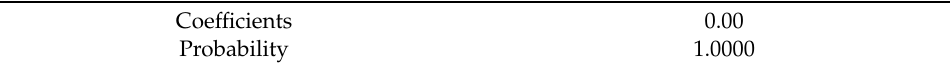
Table A2. Breusch and Pagan Lagrangian multiplier test for random effects.